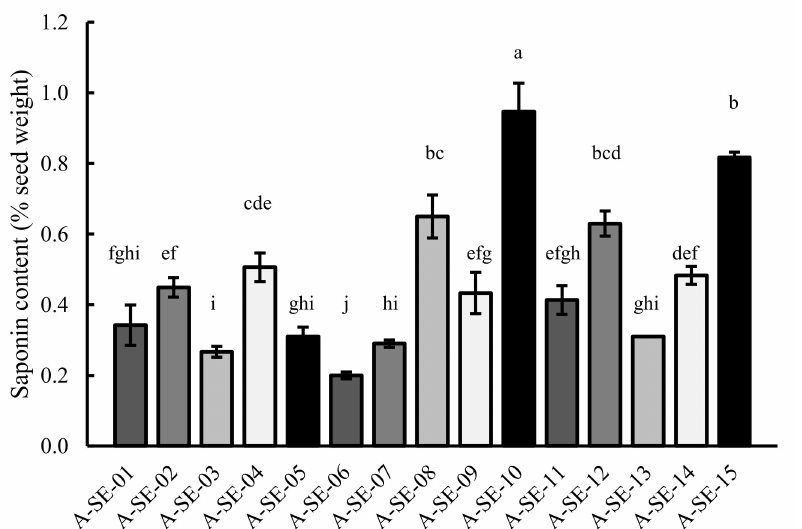
Figure 8. Saponin content. Saponin content was determined in seeds of the 15 cultivars evaluated. Error bars represent the standard deviation. Bars that do not share the same letters show statistically significant differences following the Kruskal–Wallis test by ranks at a p -value <